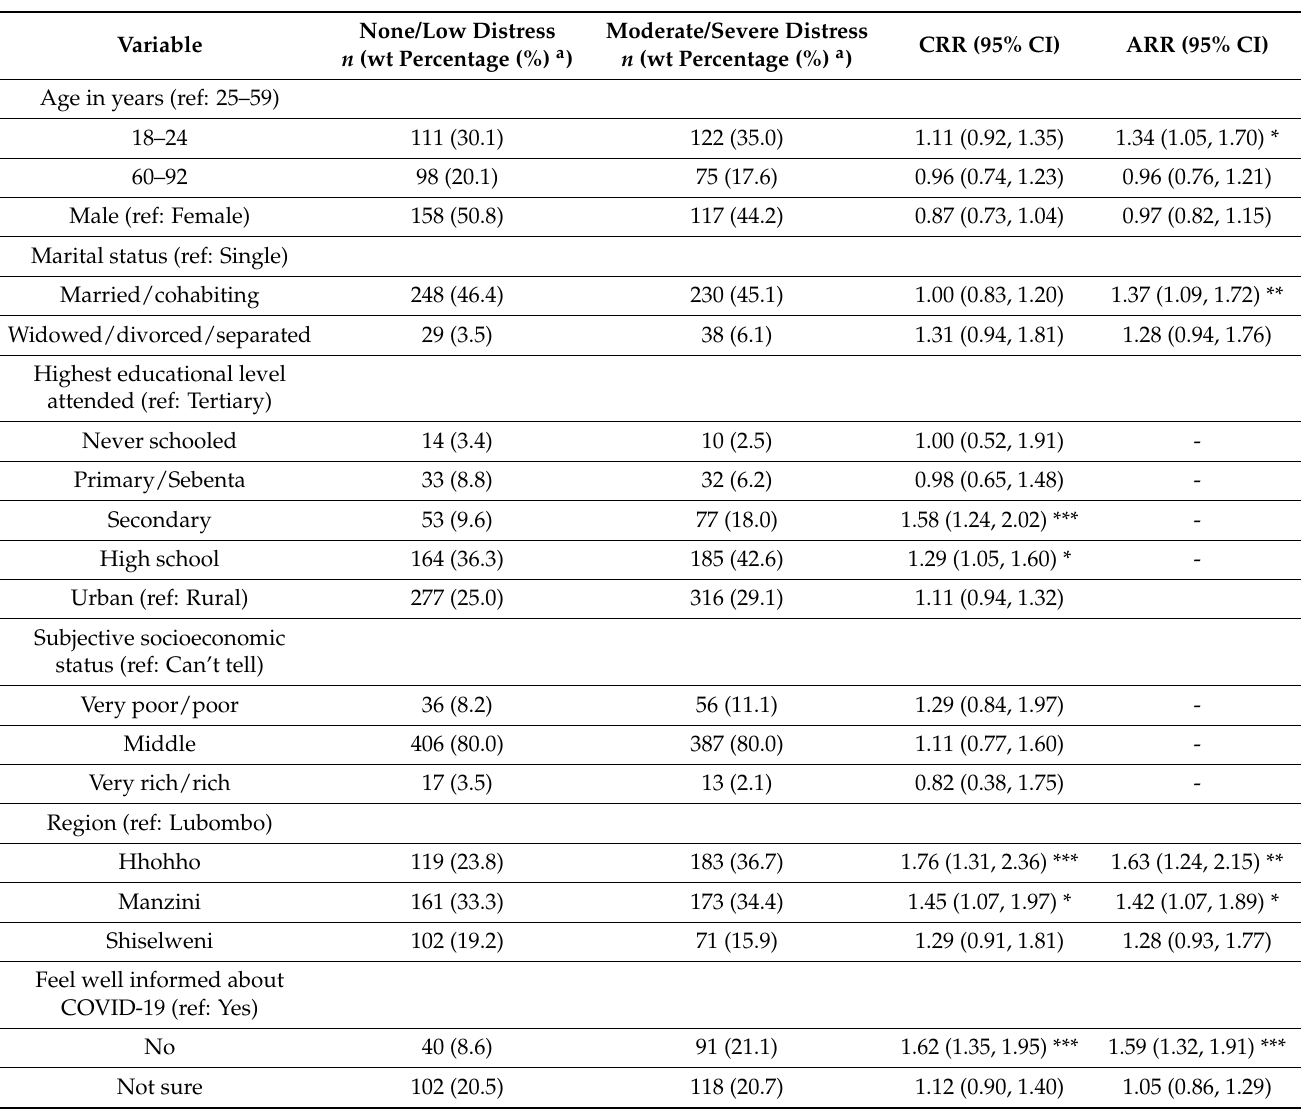
Table 4. Weighted modified Poisson regression models depicting predictors of moderate/severe psychological distress among adults during the COVID-19 pandemic in Eswatini ( N =